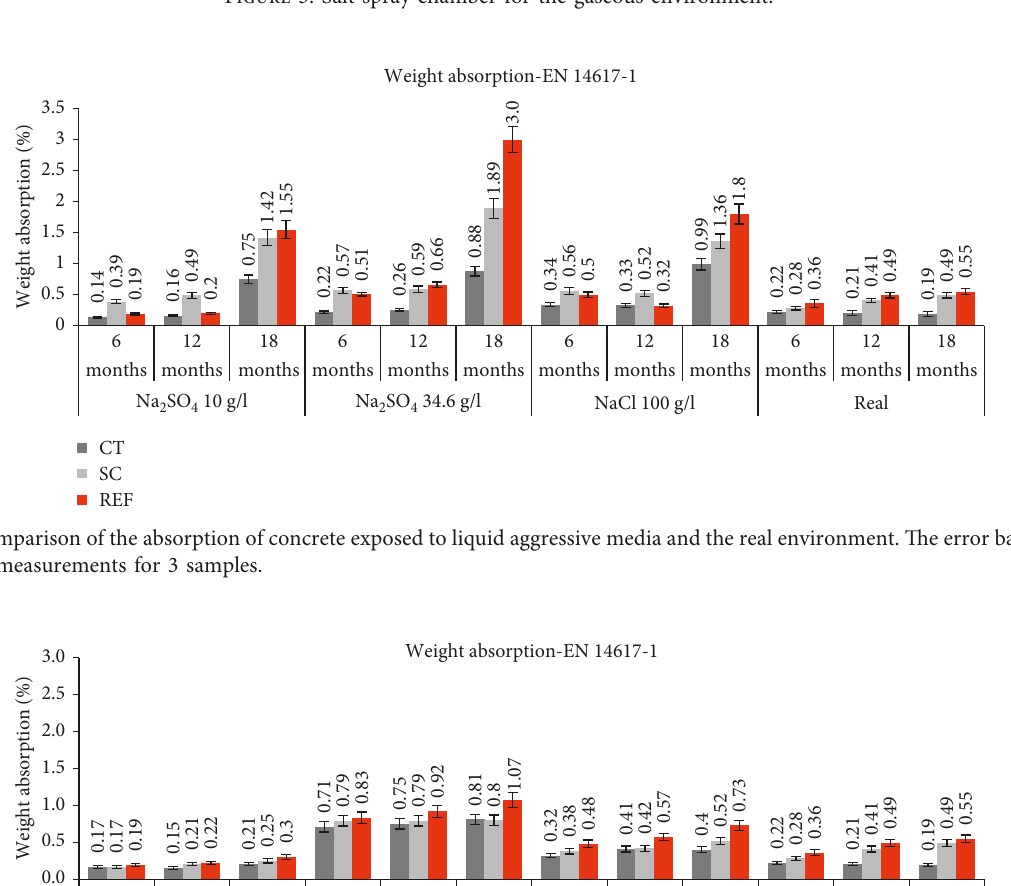
Figure 5: Salt spray chamber for the gaseous